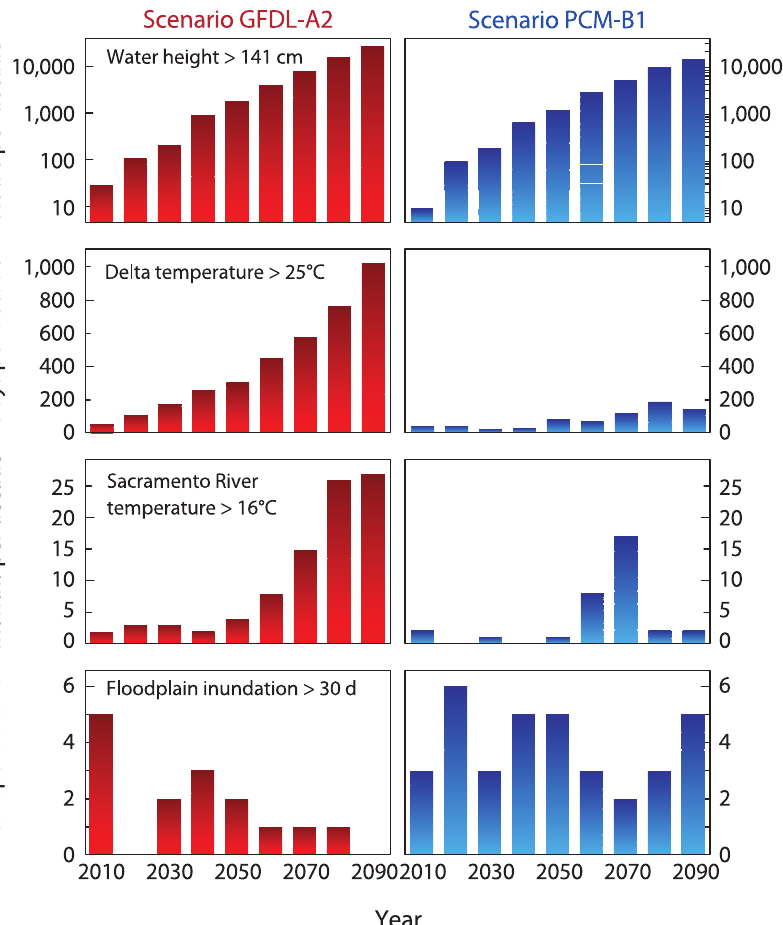
Figure 4. Projected 2010–2099 changes in the occurrence of extreme environmental conditions in the San Francisco Estuary- Watershed system for the A2 (left) and B1 (right) scenarios. The indicators count projected exceedences each decade of threshold values based on historical extreme water elevation or having significance for sustainability of native species of fish (lethal water temperatures) or habitat restoration through management of floodplain habitats.